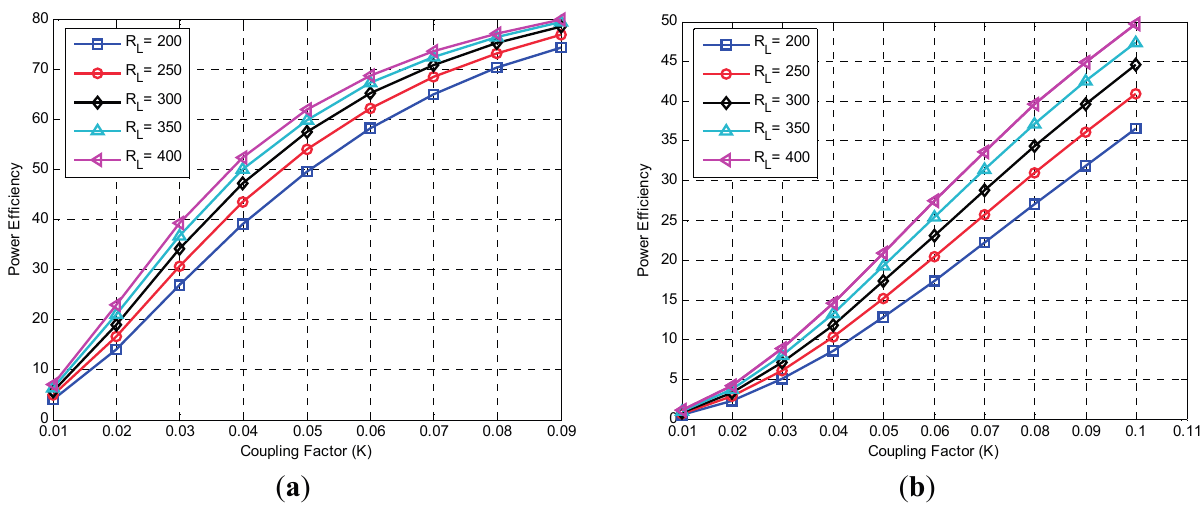
Figure 6. Power efficiency links ( a ) with low and high impedance; ( b ) with low input impedance and various load resistances.